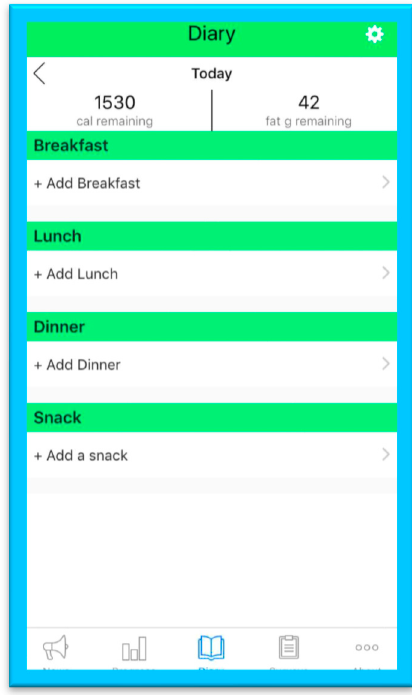
Figure 1. Screen capture of the Bridge2U mobile food log.